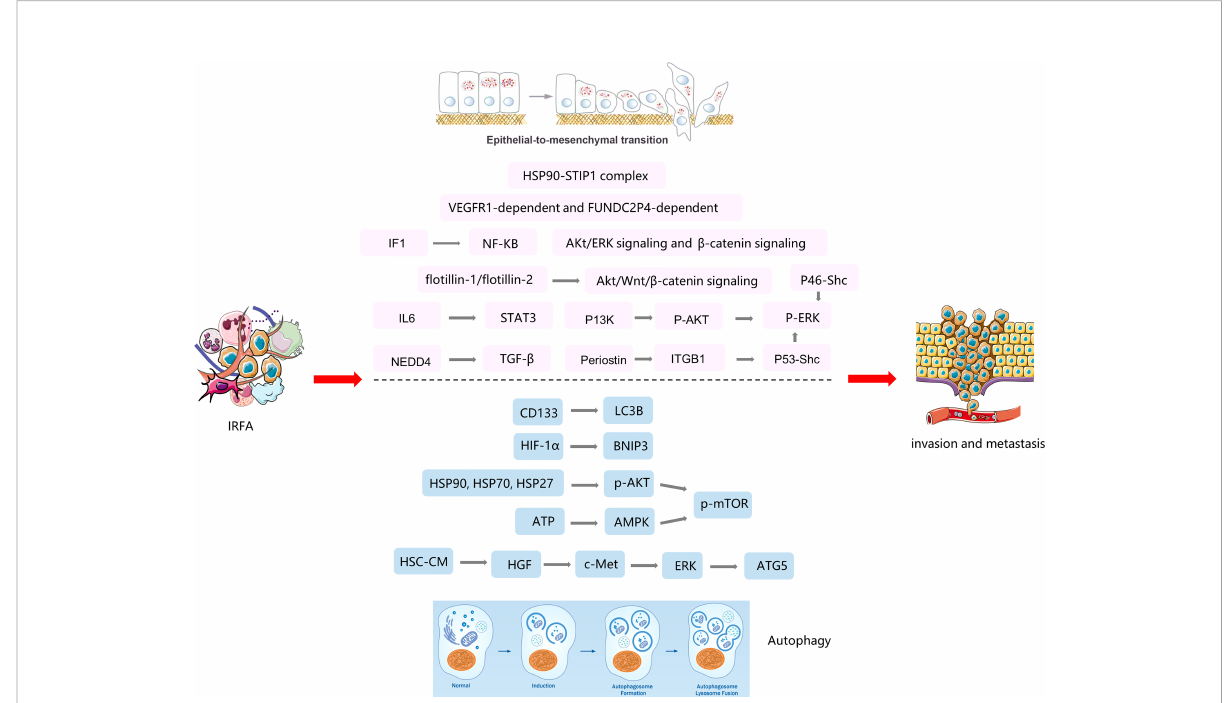
FIGURE 2 The mechanisms of EMT and autophagy in tumor progression after insuf fi cient RFA(IRFA) of